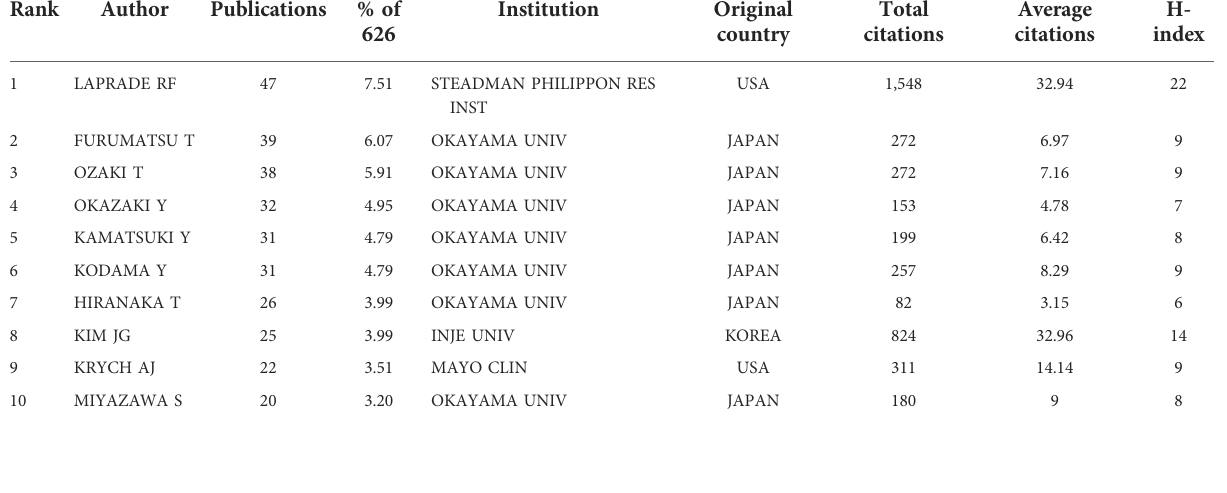
TABLE 4 Top 10 authors distributed by publications and citations.